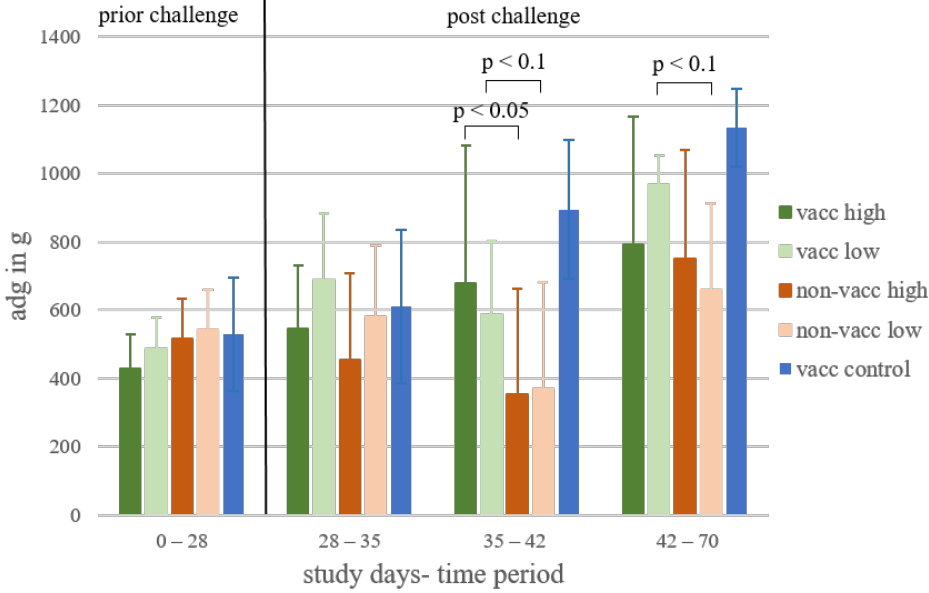
Figure 4. Average daily weight gain. Mean and standard deviation of average daily weight gain (ADG) for each treatment group (vacc high: vaccinated, high dose [10 5 TCID 50 /dose] infected; vacc low: vaccinated, low dose [10 3 TCID 50 /dose] infected; non-vacc high: non-vaccinated, high dose infected; non-vacc low: non-vaccinated, low dose infected; vacc control: vaccinated, non-infected) for the different time periods: prior to infection, the first and second weeks after infection, and from two weeks after infection until termination. p -values < 0.05 and < 0.1 are indicated using brackets.